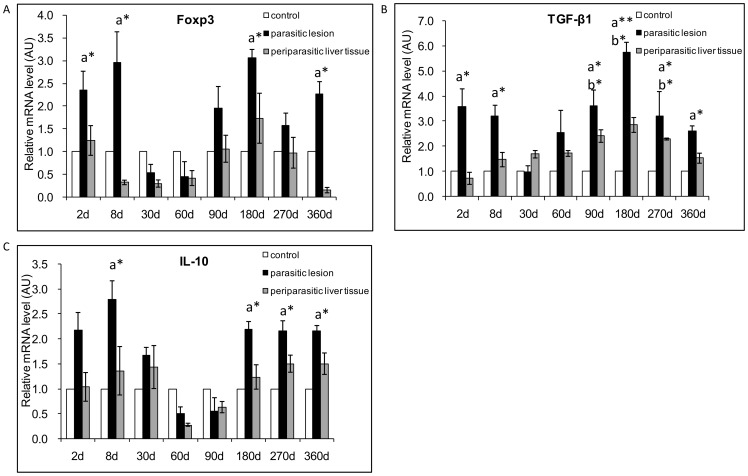
Course of Treg transcription factor and Treg-cytokine gene expression in the liver of mice during E. multilocularis infection (measured by q RT-PCR).(A) Foxp3, (B) TGF-β1, (C) IL-10. a: ‘Parasitic lesion’ versus ‘Control’; b: ‘Periparasitic liver tissue’ versus ‘Control’. *P<0.05; **P<0.01. ‘Control’, non-infected mice; ‘Parasitic lesion’: E. multilocularis metacestode and surrounding immune infiltrate; ‘Periparasitic liver tissue: liver parenchyma close to the E. multilocularis lesion, but excluding macroscopically visible liver tissue alterations. AU: arbitrary units.